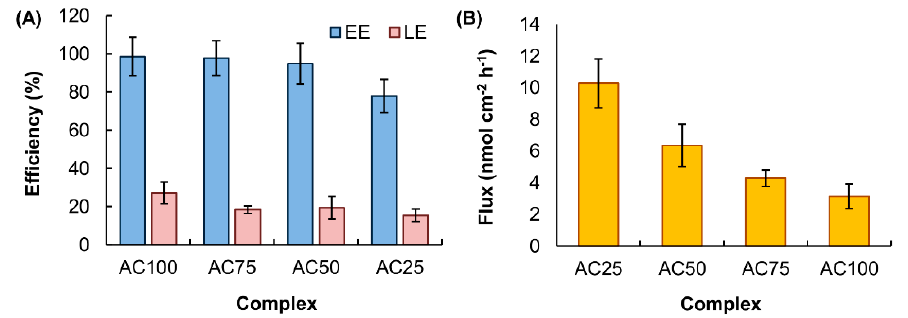
Figure 8. ( A ) The EE and LE of complex gels with different mass percentages of CMC-Na. Data are presented as the means ± SD of triplicate experiments. ( B ) The transdermal flux of THSG from different V-THSG-loaded complex gels. Data are presented as the means ± SD of triplicate experiments.